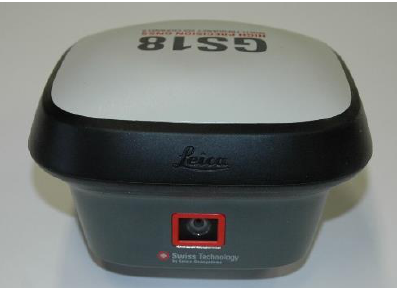
Figure 1 . The Leica GS18i GNSS receiver with the camera, in the